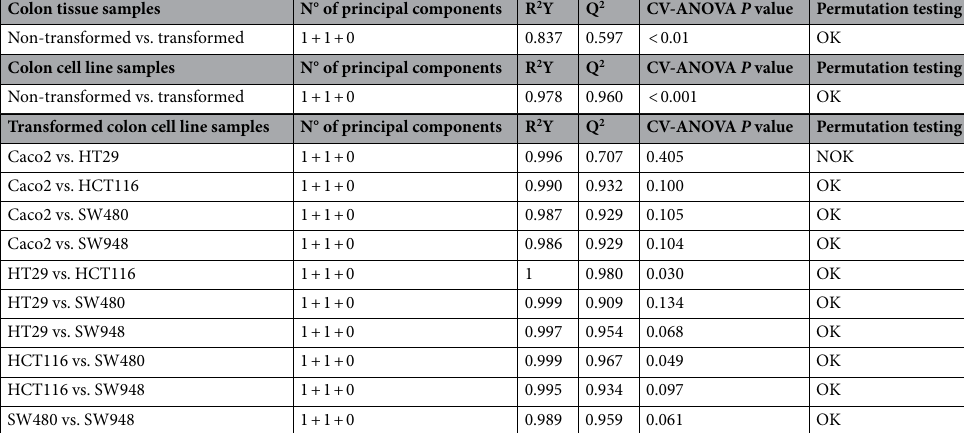
Table 2. Validation parameter values of OPLS-DA models using solely the discriminative metabolites. 35 and 52 discriminative metabolites (VIP value > 1.0 and/or P value > 0.05) were used to construct OPLS-DA models for colon tissue and cell lines, respectively.